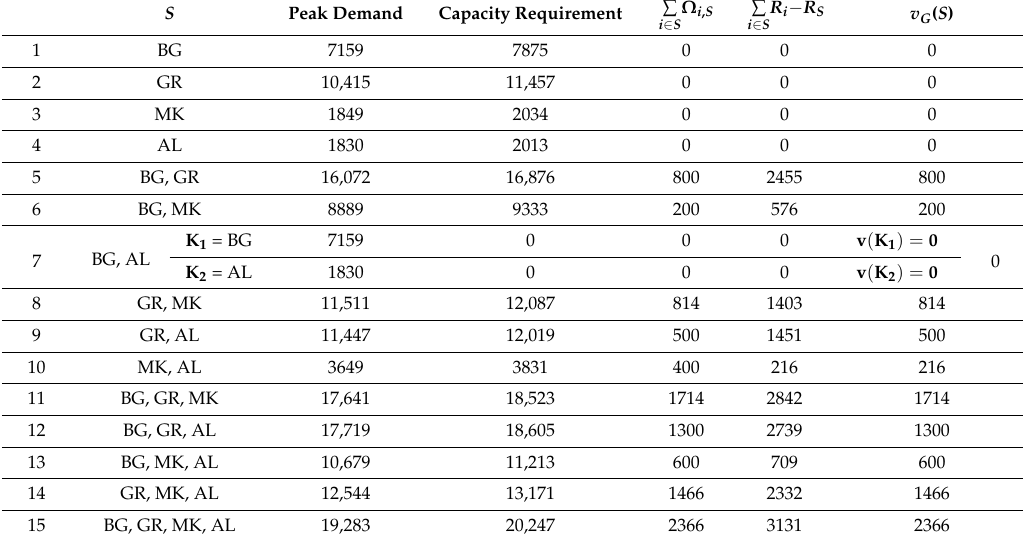
Table 4. Data and characteristic values for the 4-country game (in MW).